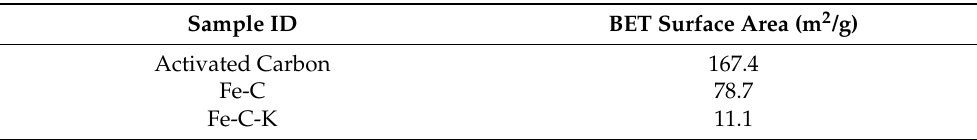
Table 2. BET surface area of activated carbon, Fe-C, and Fe-C-K